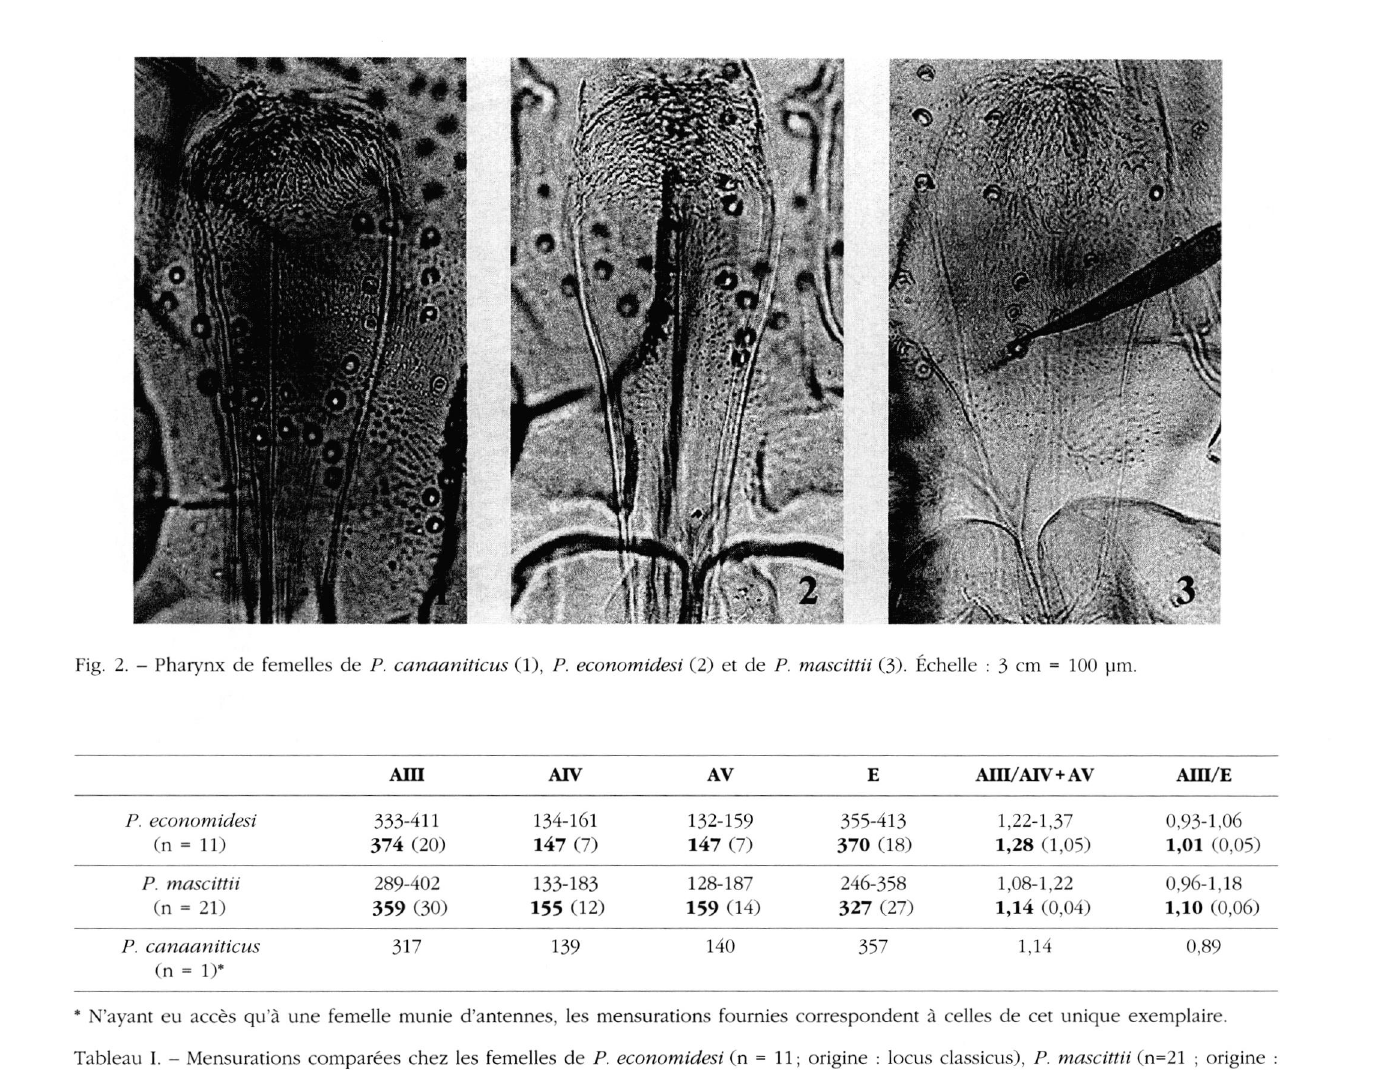
Tableau I. - Mensurations comparées chez les femelles de P. economidesi (n =11; origine : locus classicus), P. mascittii (n=21 ; origine : Auvergne) et P. canaaniticus (n = 1; origine : Liban). Pour chaque organe mesuré sont indiqués les valeurs minimale et maximale, la moyenne (en caractères gras) et l'écart-type (entre parenthèses). E = épipharynx.